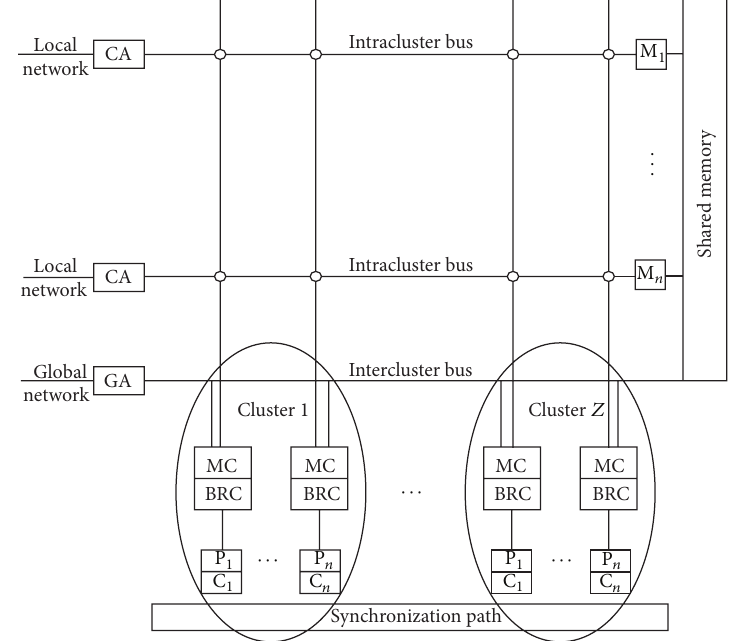
Figure 1: Shared memory cluster architecture